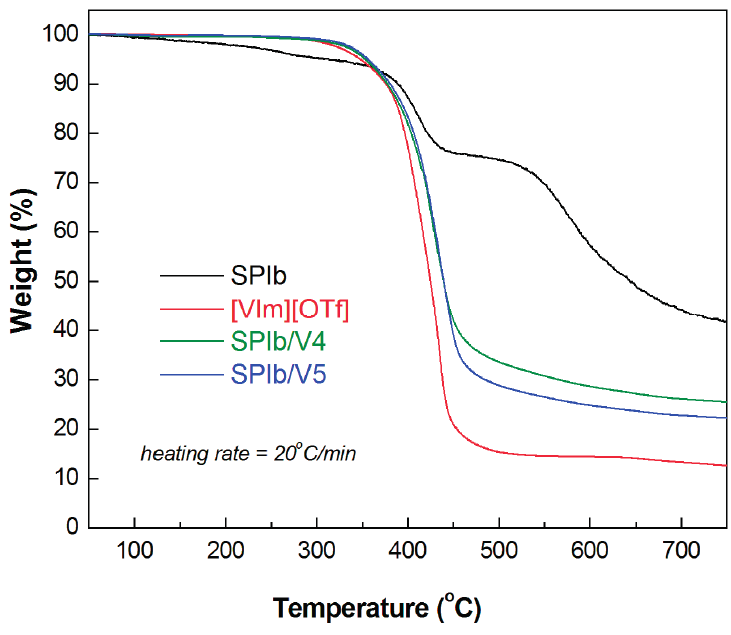
Figure 6. TGA scans of SPIb, ILs and SPIb/IL composite